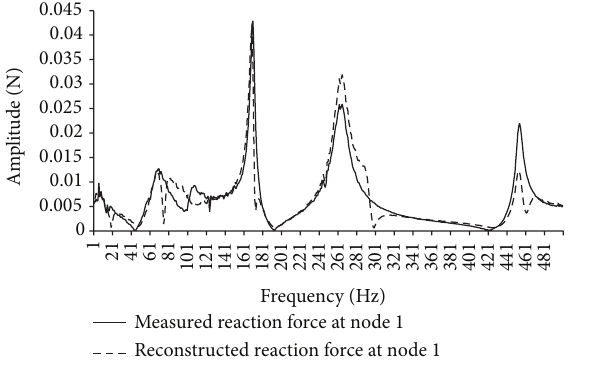
Figure 10: Experimental and estimated force reaction 𝐹 1 .